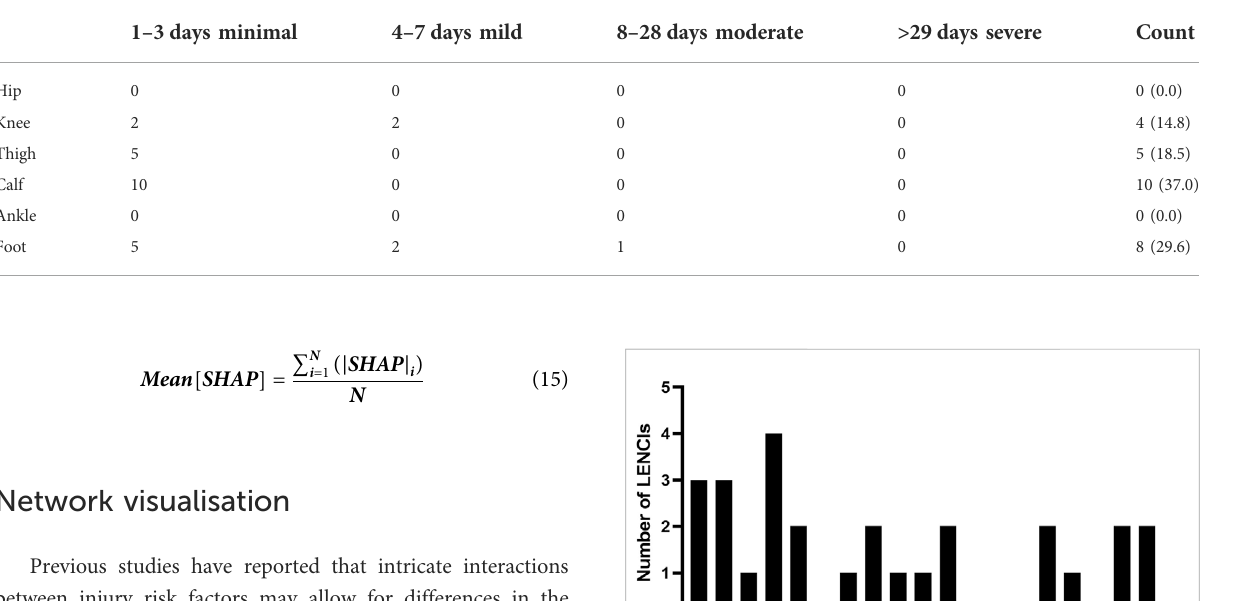
TABLE 2 Descriptive information on the incidence of non-contact injuries of all lower extremities.